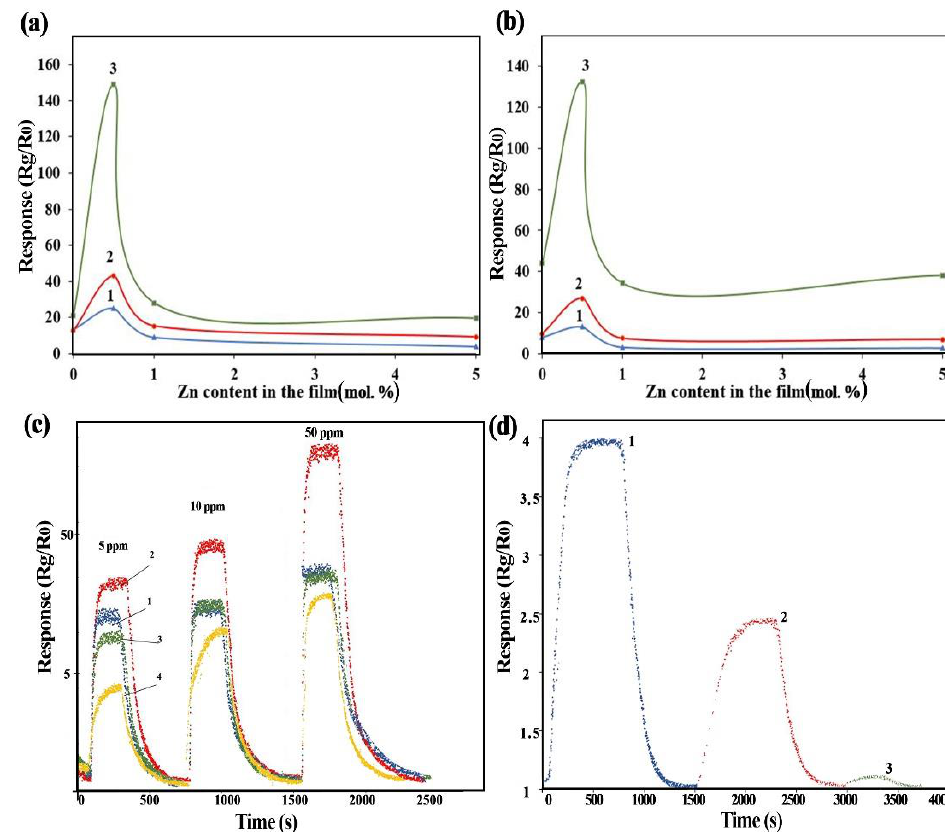
Figure 10. The dependences of the ZnO-SnO 2 gas sensors response on exposure to NO 2 concentra- tions of 5 ppm (1), 10 ppm (2) and 50 ppm (3) at 200 °C ( a ), 250 °C ( b ) and ( c ) the normalized response of gas sensors based on ZnO-SnO 2 films ( c ): 0ZnO (1), 0.5ZnO (2), 1ZnO (3) and 5ZnO (4) when exposed to NO 2 concentrations of 5, 10, and 50 ppm, and ( d ) 0.5: 99.5 when exposed to NO 2 concen-